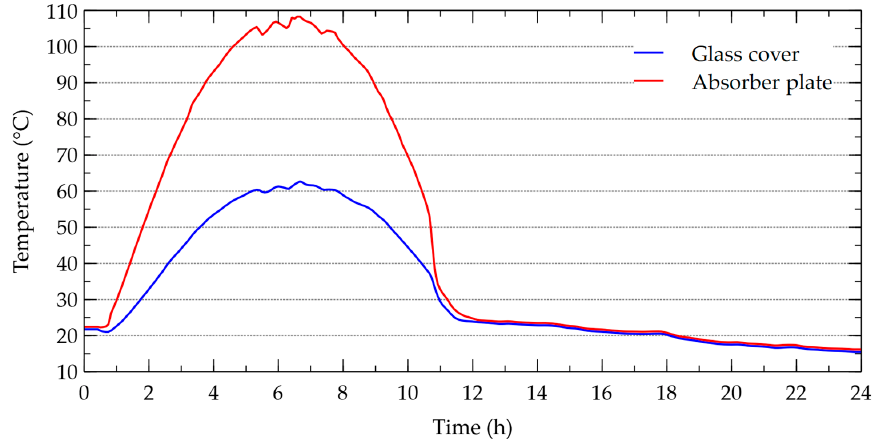
Figure 11. Estimated temperatures of components in case 3.